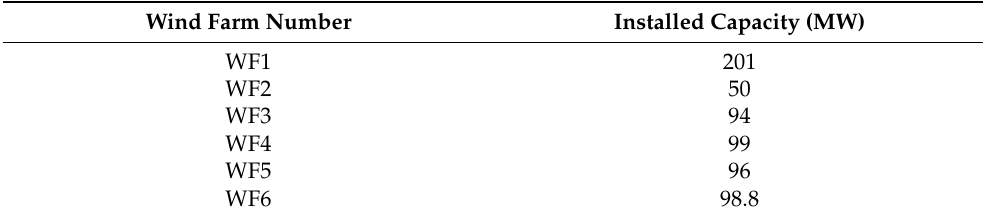
Table 3. Wind farm installed